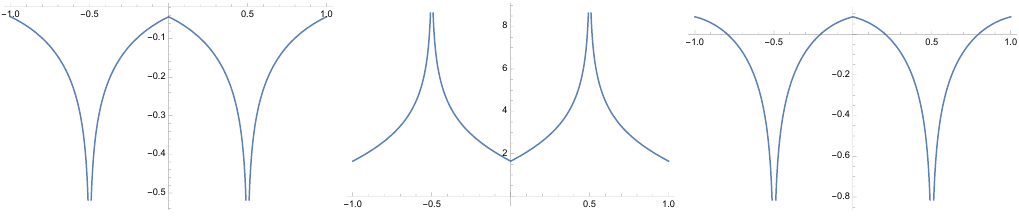
Figure 1 . For Solution II + , the three functions A ( r ) , χ ( r ) and B ( r ) are shown for R = 1 in a double period r ∈ [ − R, R ]